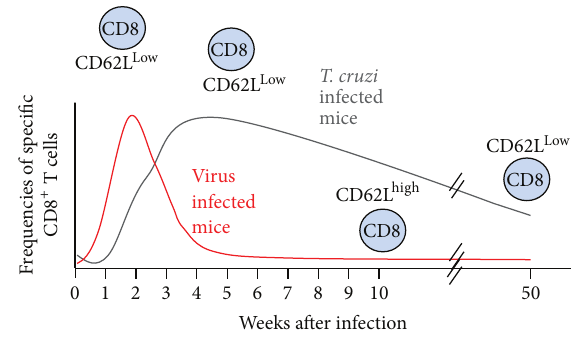
Figure 1: Kinetics of the immune response mediated by CD8 +